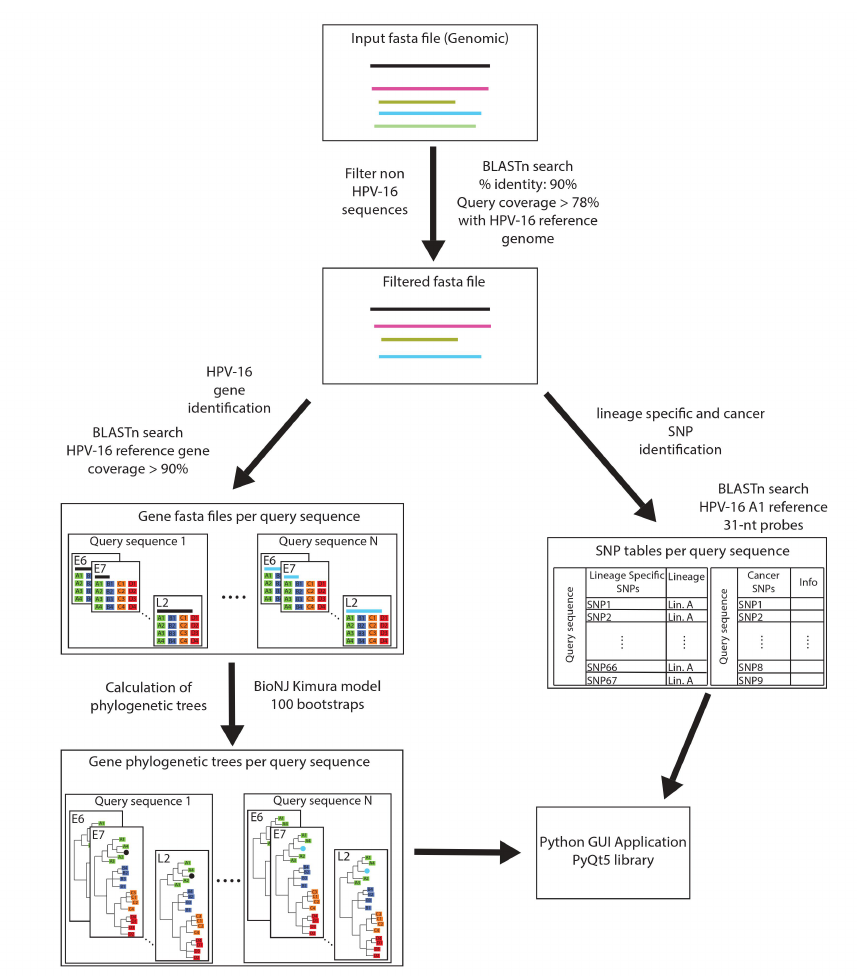
Figure 1. A workflow of the HPV16-genotyper